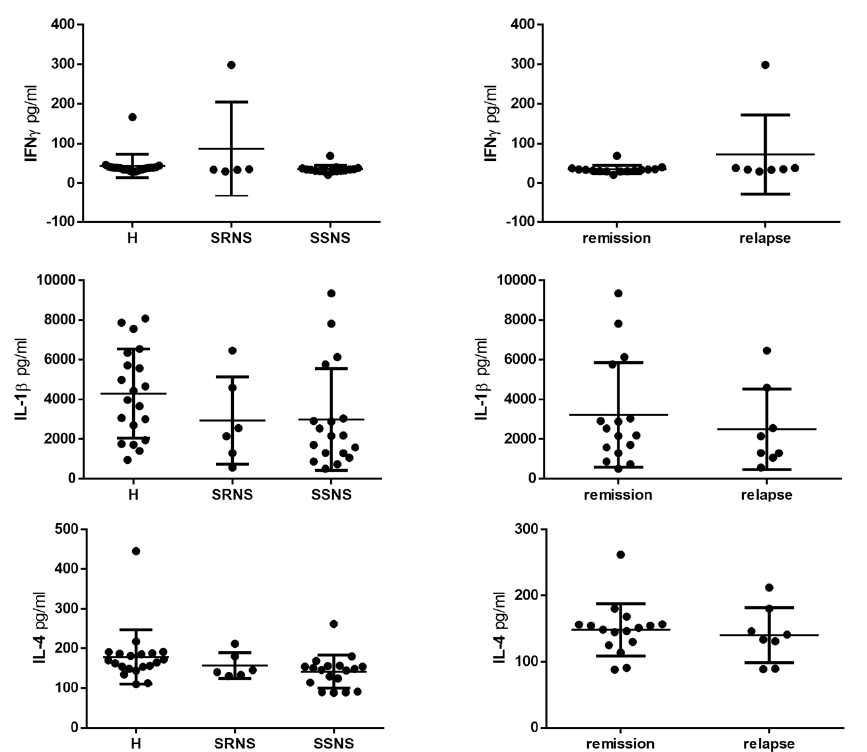
Figure 3. Levels of IL1 β , IFN γ , and IL-4 from the saliva of children with nephrotic syndrome and healthy controls. Samples from children with nephrotic syndrome were classified according to steroid-resistant nephrotic syndrome (SRNS) and steroid-sensitive nephrotic syndrome (SSNS); and according to the remission and relapse states. Levels of IL1 β , IFN γ , and IL-4 were quantified by ELISA. The values are presented as means and SD.